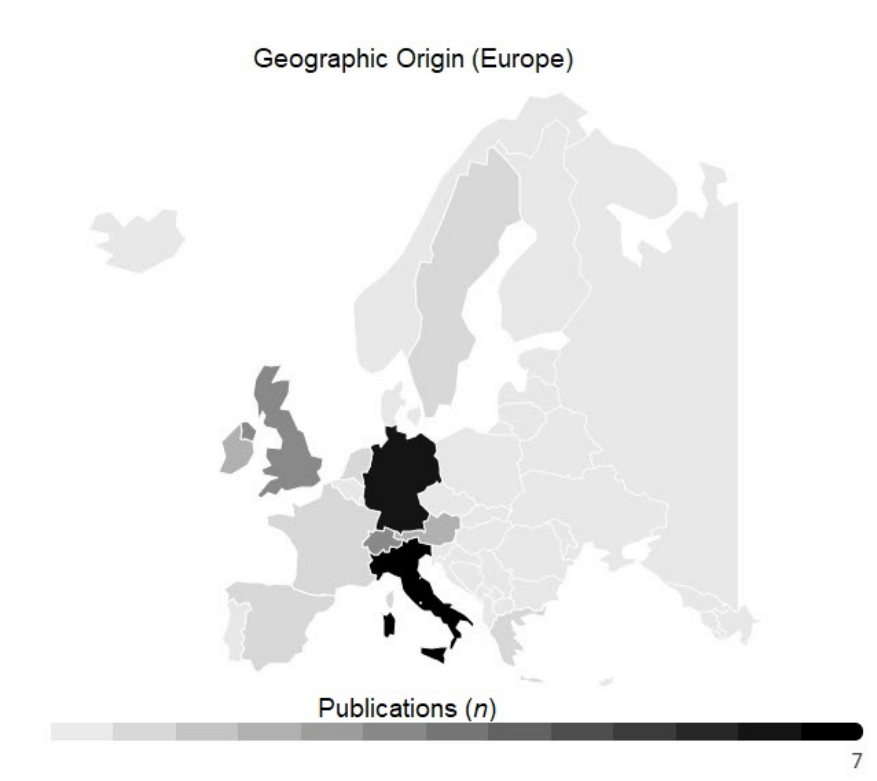
Figure 3. Geographic origin of publications in relation to proportion of older population. Within Europe, most publications were from Italy ( n = 7), followed by Germany ( n = 6), United Kingdom ( n = 3) and Switzerland ( n = 3), Austria ( n = 2), Ireland ( n = 2); Spain, France, Greece, the Netherlands, and Sweden reported one article each (Figure 4).